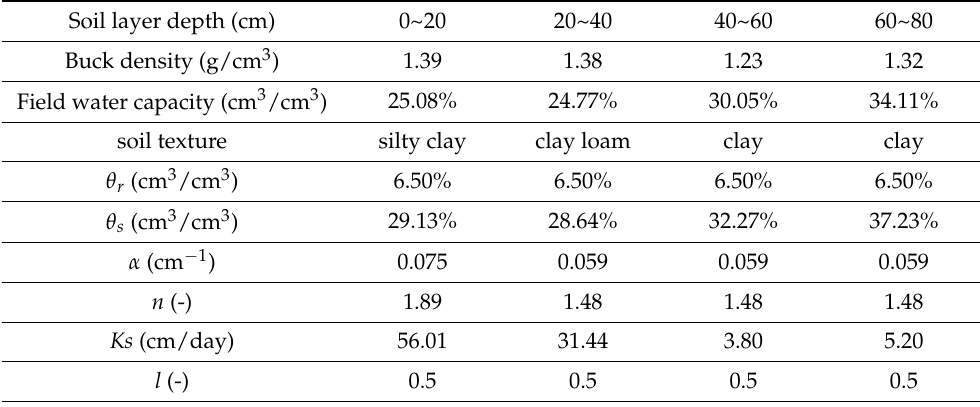
Table 1. Soil parameters of each layer.